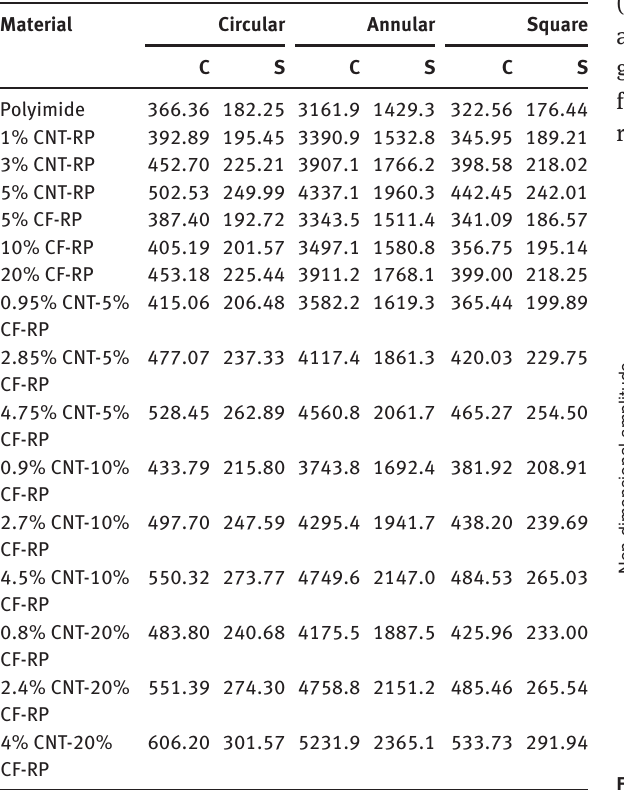
Table 4: Fundamental frequencies (Hz) of plates with different shapes and made of various materials.